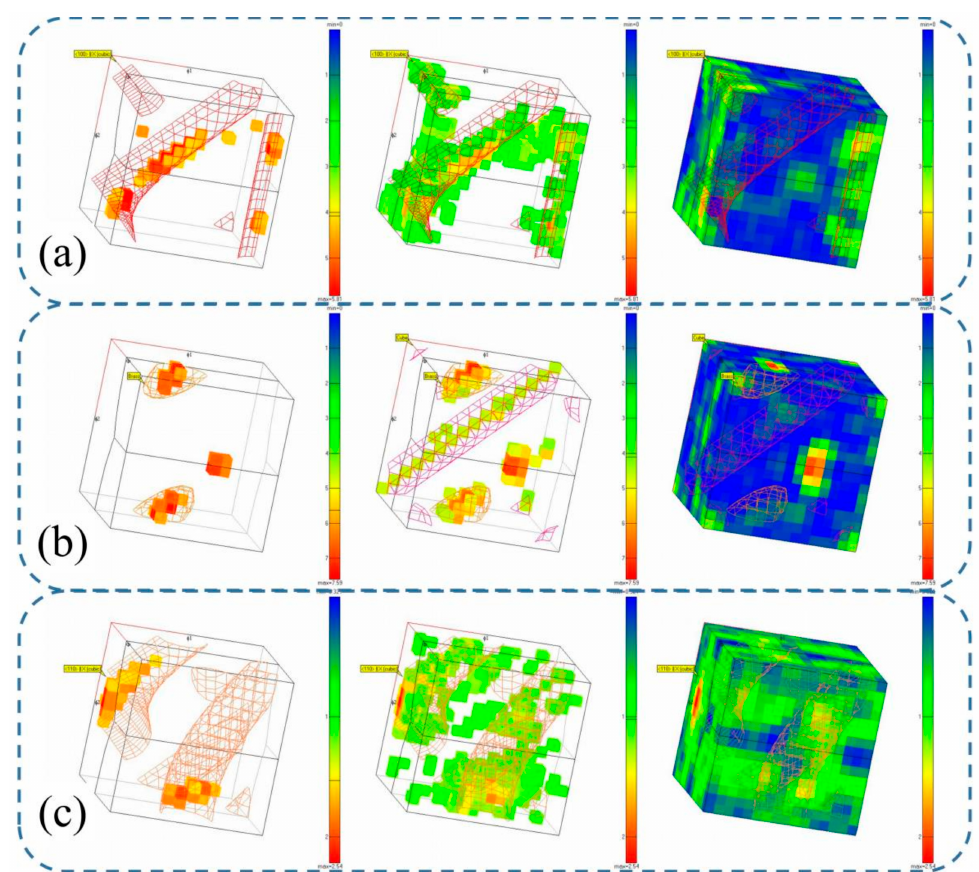
Figure 10. Optimal decision function (ODF) orientation map of specimens. ( a ) No change of heat input and no cooling (Specimen A). ( b ) No change of heat input, cooling between layers (Specimen B). ( c ) Change of heat input without inter-layer cooling (Specimen D). The grid is the region with strong texture strength for different kinds of textures; the regions with higher texture strength of alloy deposits treated by different processes are accurately distributed in the standard